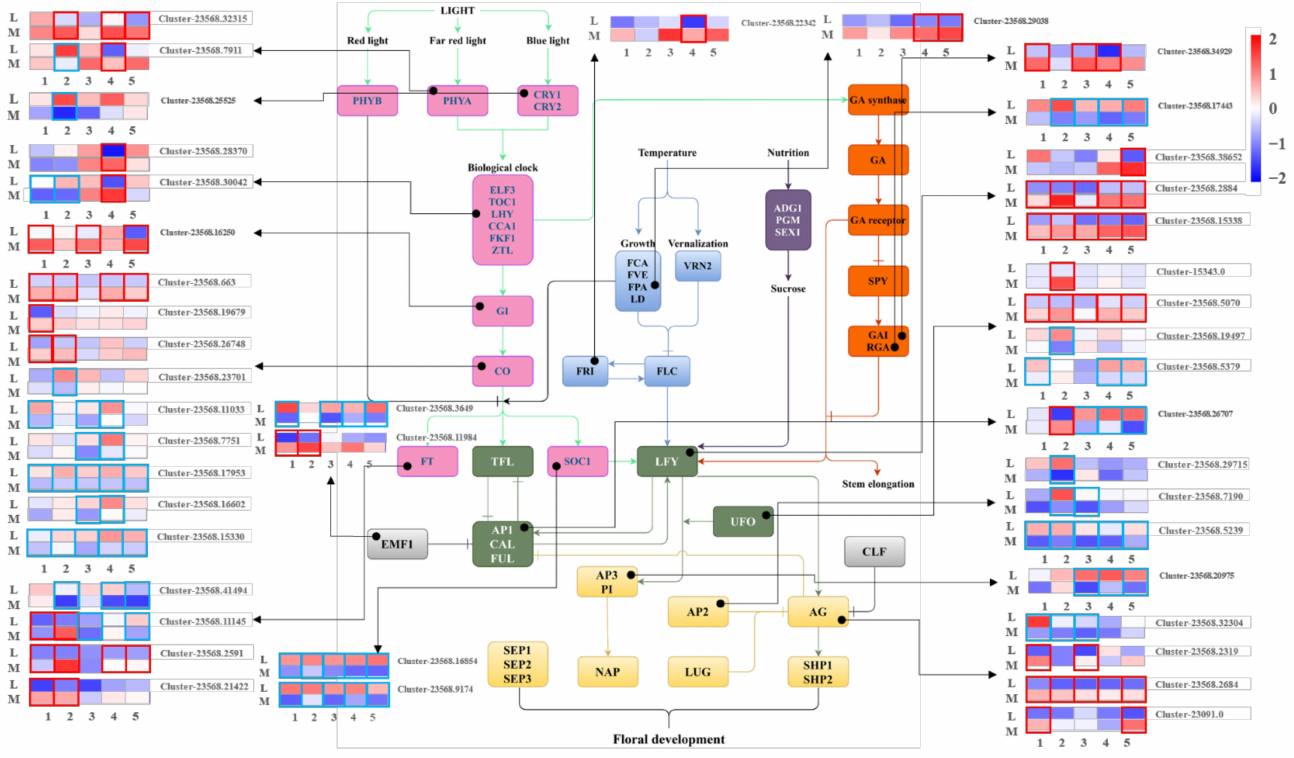
Figure 9. Differentially expressed flowering D. pectinatum unigenes identified in comparisons between leaf and male cone tissues. The gradient-colored barcode at the top right indicates the log2(FC) value. Fold change is calculated based on the difference multiple of FPKM in different periods. The unigenes expression in male cone was significantly higher than leaves, which was framed in red box, and lower was in blue box. 1~5: 8 April, 10 May, 3 June, 3 July, and 11